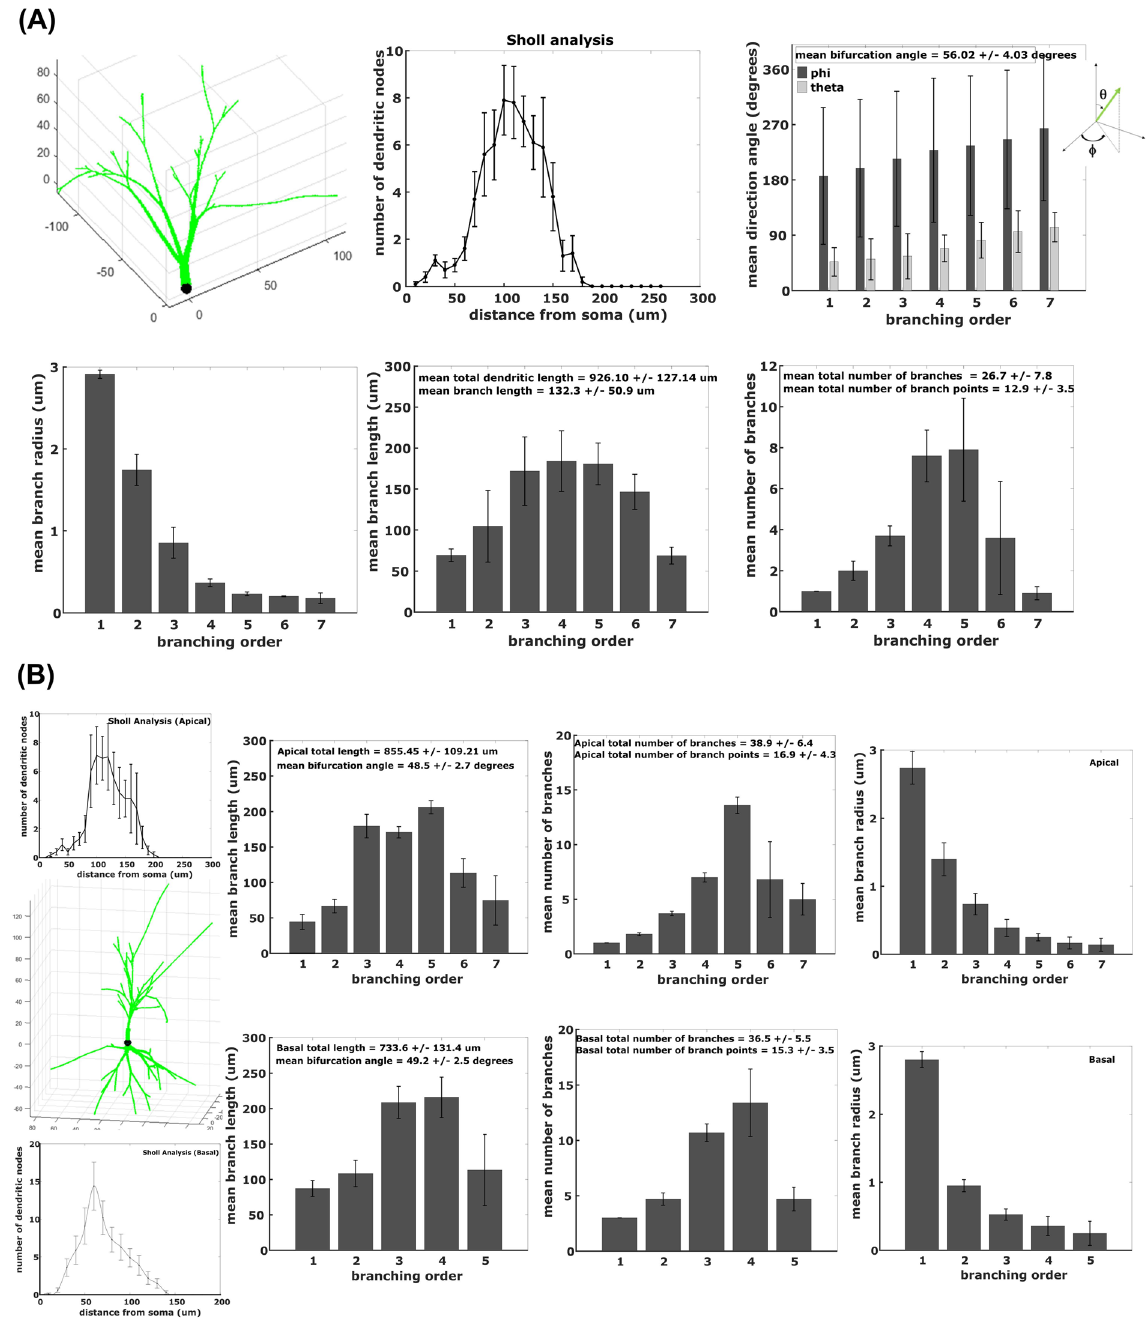
Figure 2. In silico representation of mouse hippocampal neurons: granule cell layer (GCL) neuron and CA1 pyramidal neuron. ( A ) GCL neuron parameters indicate bifurcation angle = 56.02 ± 4.03°, total dendritic length = 926.10 ± 127.14 μ m, branch length = 132.3 ± 50.09 μ m, branch number = 26.7 ± 7.8 and number of branch points = 12.9 ± 3.5. ( B ) CA1 pyramidal neuron parameters reveal apical total dendritic length = 855.45 ± 109.21 μ m, apical bifurcation angle = 48.5 ± 2.7°, apical branch number = 38.9 ± 6.4, apical number of branch points = 16.9 ± 4.3, basal total dendritic length = 733.6 ± 131.4 μ m, basal bifurcation angle = 49.2 ± 2.5°, basal branch number = 36.5 ± 5.5 and basal number of branch points = 15.3 ± 3.5. Error bars represent standard deviation from 10